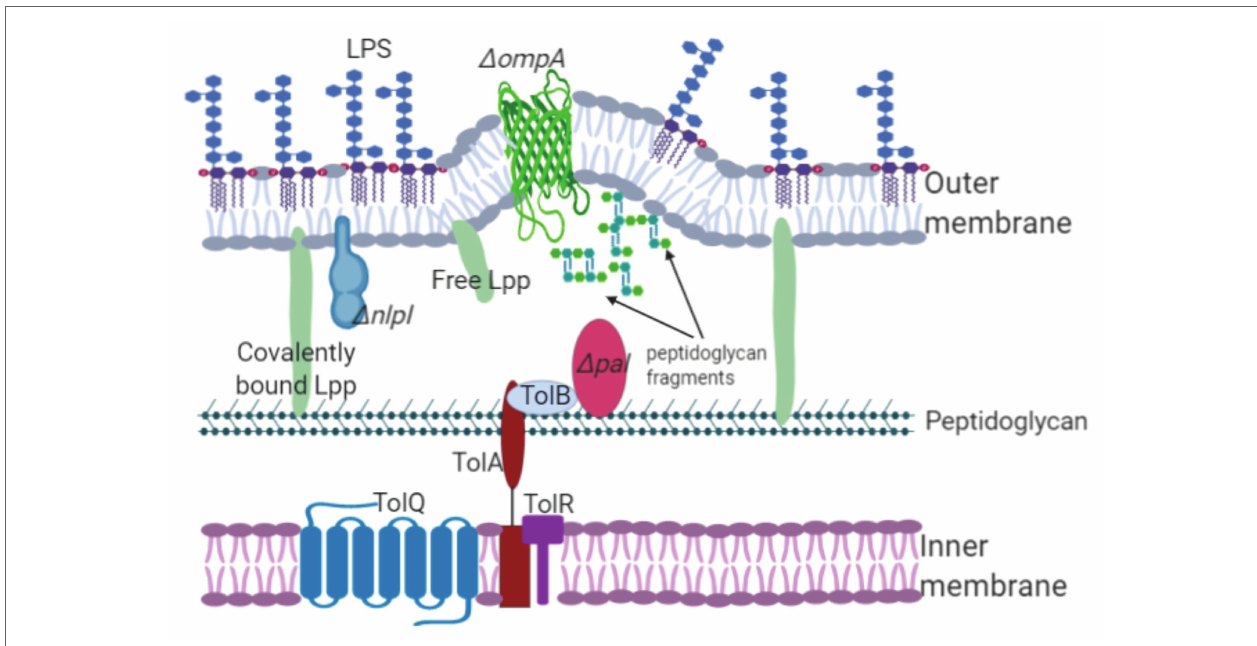
FIGURE 1 | Lipoproteins and outer membrane proteins are involved in OMV biogenesis. The Lpp, NlpI, OmpA, and Tol-Pal members maintain the stability of cellular envelopes joining the peptidoglycan layer with the inner membrane. Interruption or deletion of the genes encoding these proteins decrease the number of linkages, inducing OMV formation. For example, mutation of the pal gene decreases linkage with the outer membrane, leading to membrane protrusion and OMV release. Additionally, the accumulation of components in the periplasm, such as peptidoglycan precursors, triggers vesicle